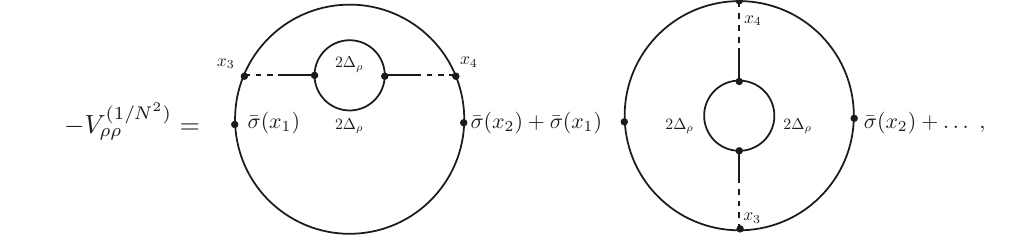
(1 /N 2 ) graphs which do not O